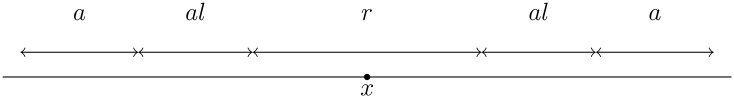
Social interaction zones.Cartoon depiction of the three social interaction zones surrounding an individual at location x. Repulsion (r) acts over short distances from the reference individual at x, alignment (al) over intermediate distances, and attraction (a) over longer distances. These zones may be disjoint, as illustrated, or may overlap.